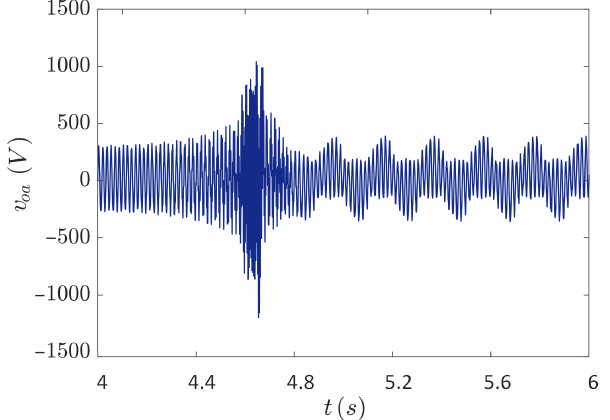
Figure 17. Voltage response on abc in P 0 = 3.89 p.u.